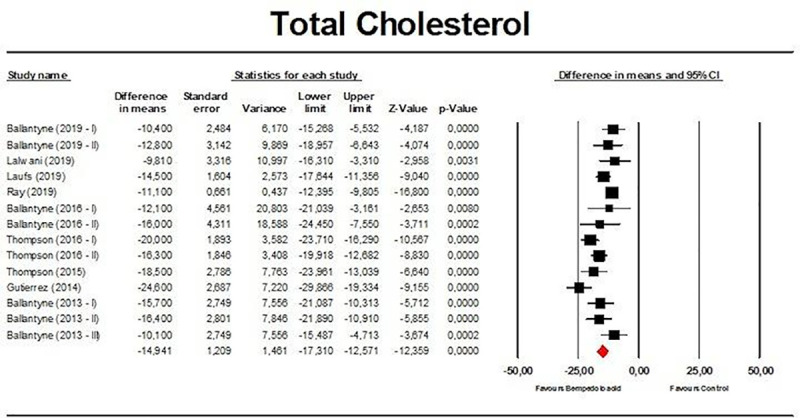
Forest plot displaying mean difference and 95% confidence intervals for the effect of bempedoic acid on plasma levels of total cholesterol.